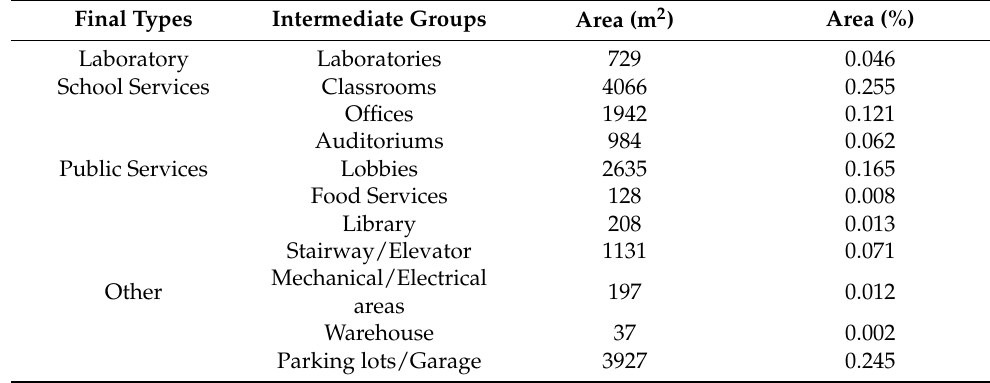
Table 1. Building Spaces and Areas (m 2